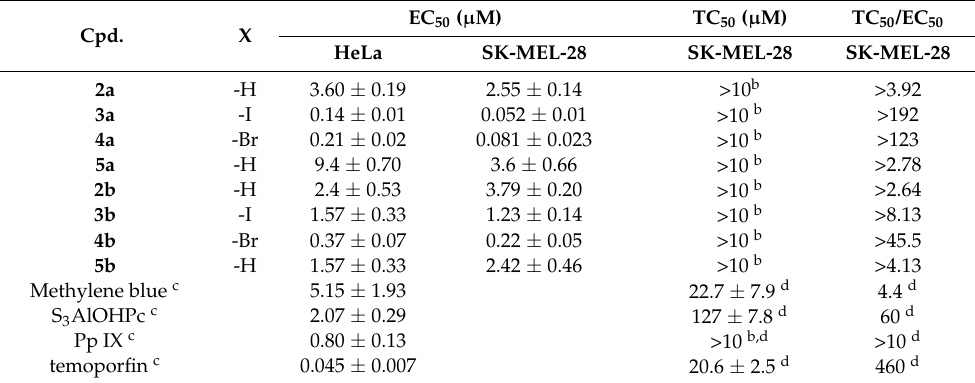
Table 2. Comparison of photodynamic parameters of the studied BODIPY dyes and structurally different PSs a . Cpd.